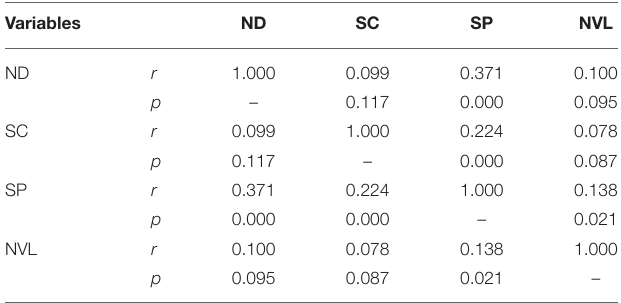
TABLE 5 | Correlations between environmental factors on the psychological fatigue.